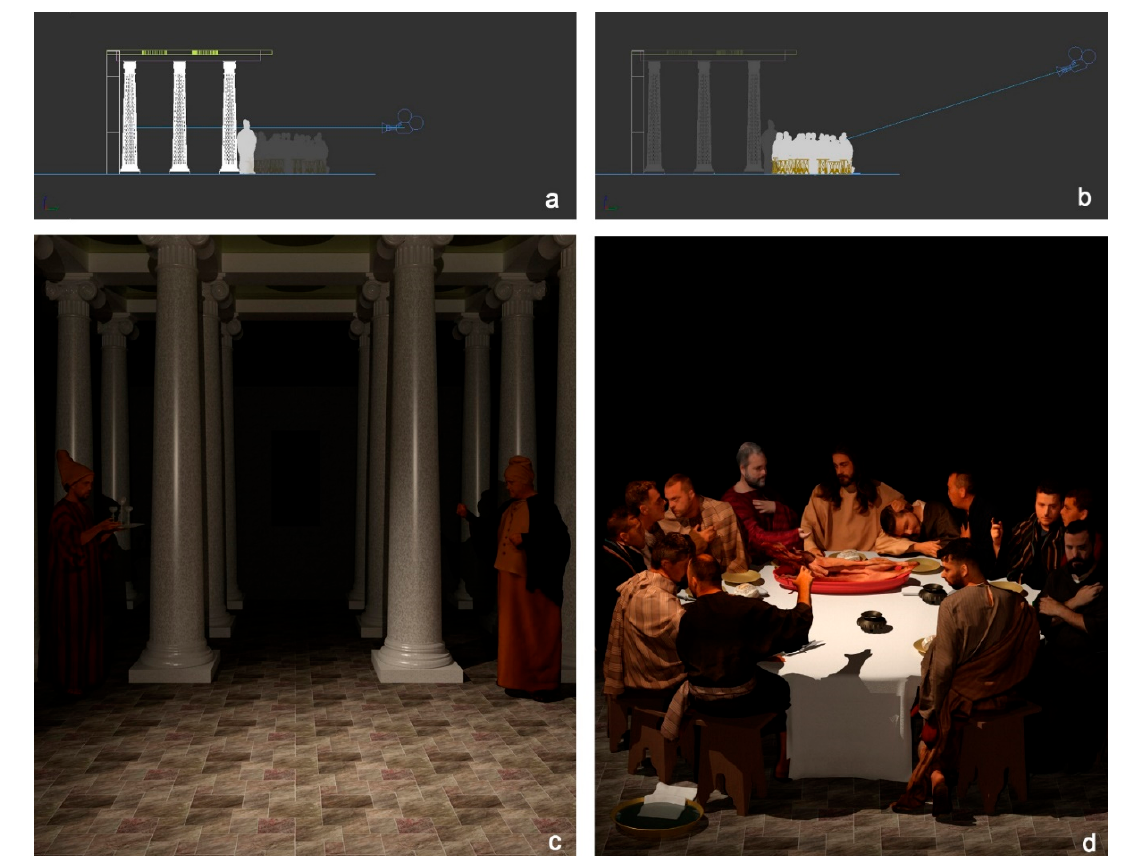
Figure 16. ( a ) Side view of the scene enlargement of the characters and position of the camera at 2.25 m from the ground (25 mm camera); ( b ) side view of the scene with enlargement of the characters and position of the camera at 6 m from the ground (50 mm camera); ( c ) G. Hovic, Last Supper.